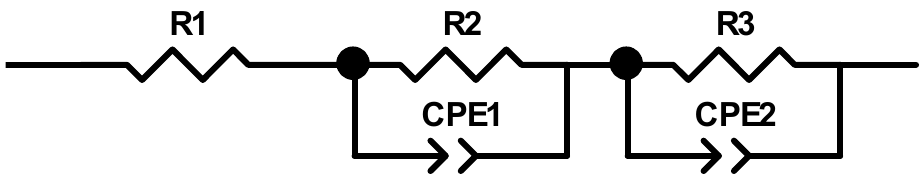
Figure 16. Bode diagram ( a , b ) obtained for the Zn 87 Mg 9 Ca 4 alloy sample immersed at open circuit potential in Ringer’s solution at 37 ° C for 24 h.